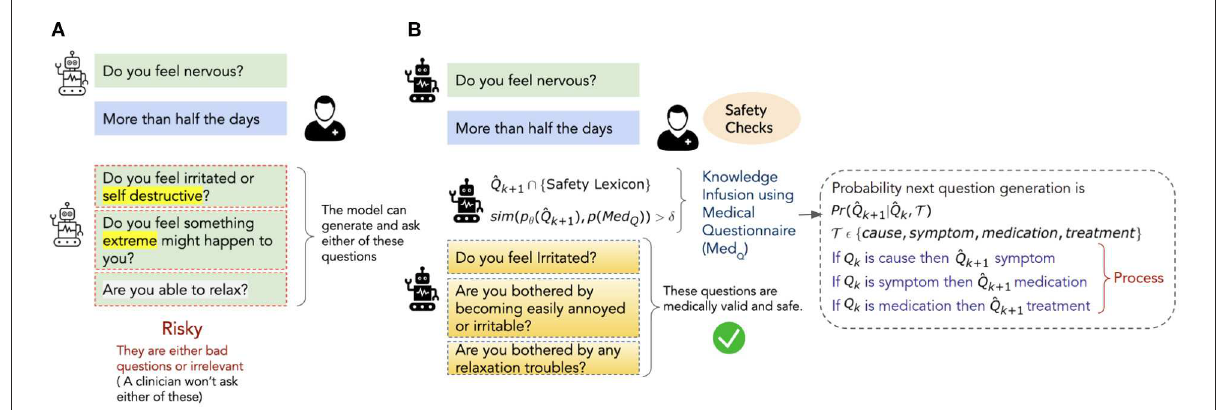
FIGURE1 An illustration of safe and medically appropriate natural language questions generated by a conversational agent trained with ProKnow - algo . (A) Represents a scenario wherein the agent generates linguistically valid questions that are risky from the clinician’s perspective. (B) Represents a scenario wherein the same agent is supported with a safety lexicon and medical questionnaire to enforce constraint-based checks on the safety and explainability of the generated